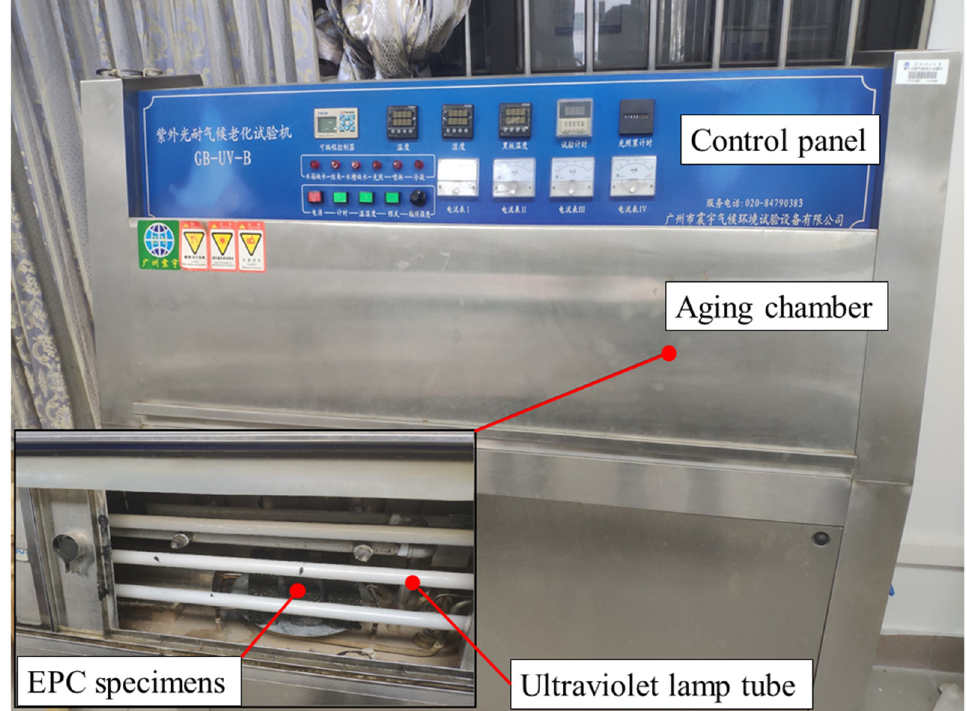
Figure 1. GB-UV-B UV weathering test chamber for accelerated aging of Epoxy Polymer Concrete (EPC).